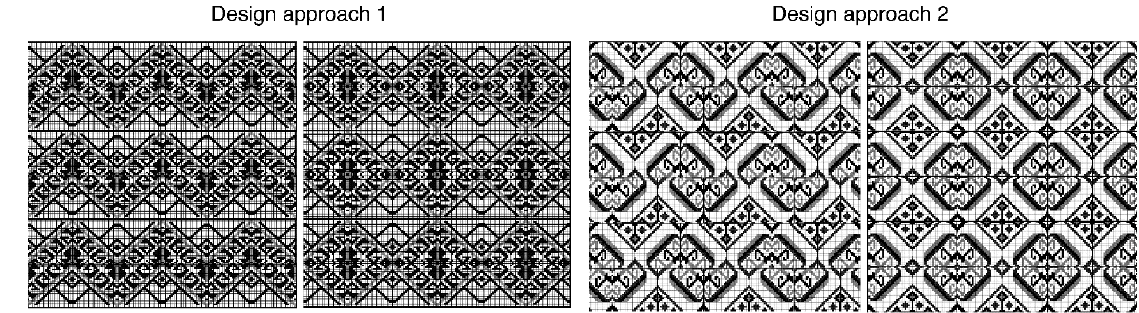
Figure 12. Two design approaches for selection. (Illustration by Kunkhet).